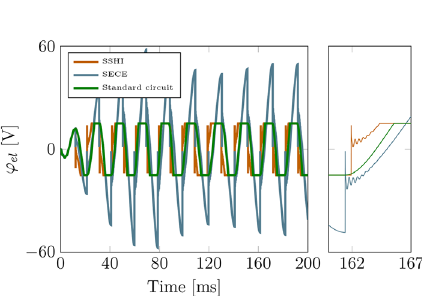
Fig. 15 Electrode voltage 𝜑 el of the bimorph PVEH with load adap- tion standard, load adaption SSHI circuit, and SECE circuit under a harmonic base acceleration of 9.81 m/s 2 and a frequency of 48.7 Hz